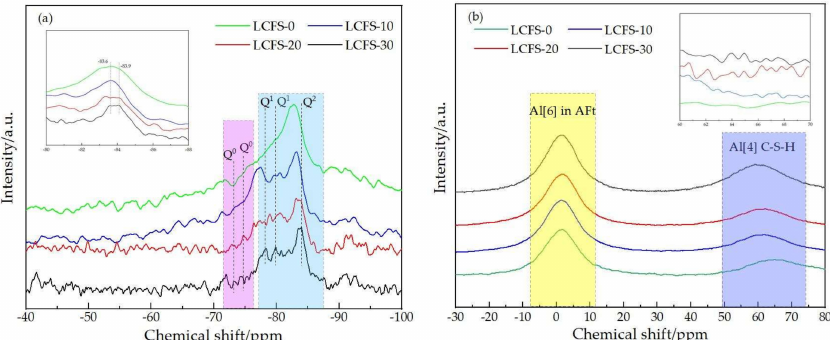
Figure 12. NMR spectra of the paste samples at 28 days: ( a ) 29Si MAS-NMR; ( b ) 27Al